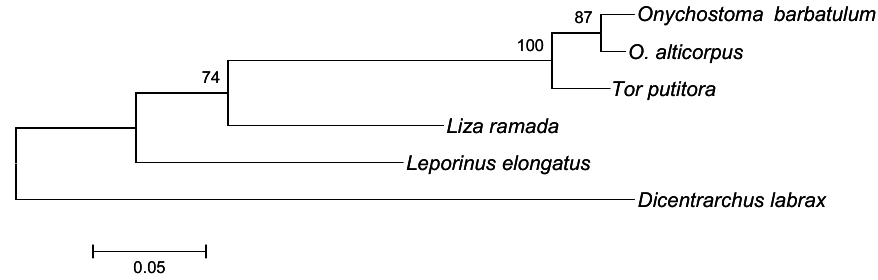
Figure 4. Neighbor-joining tree reconstructed based on 5S rDNA sequences from two Onychostoma species and four reference sequences from NCBI GenBank: Tor putitora , Leporinus elongatus , Liza ramada , and Dicentrarchus labrax . The scale bar indicates the nucleotide diversity between sequences. The bootstrapping value of each branch is shown in front of the node.